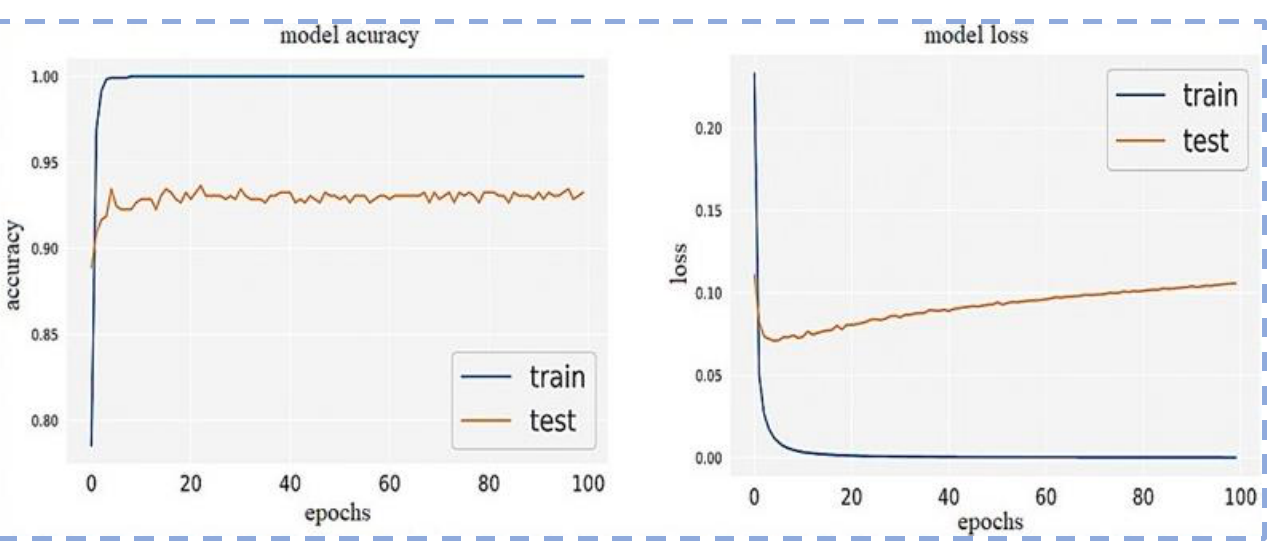
Figure 8. Model loss and Model accuracy using VGG16.